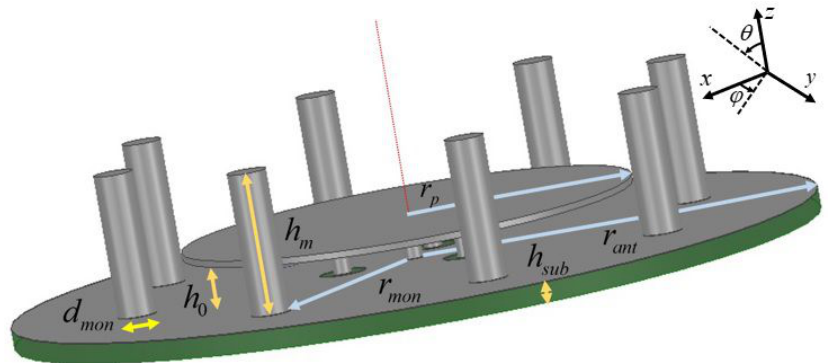
Figure 1. Side-view of the proposed sequential-fed patch antenna loaded by monopoles properly designed to increase the antenna gain close to end-fire direction, in which the relevant geometrical parameters are highlighted.